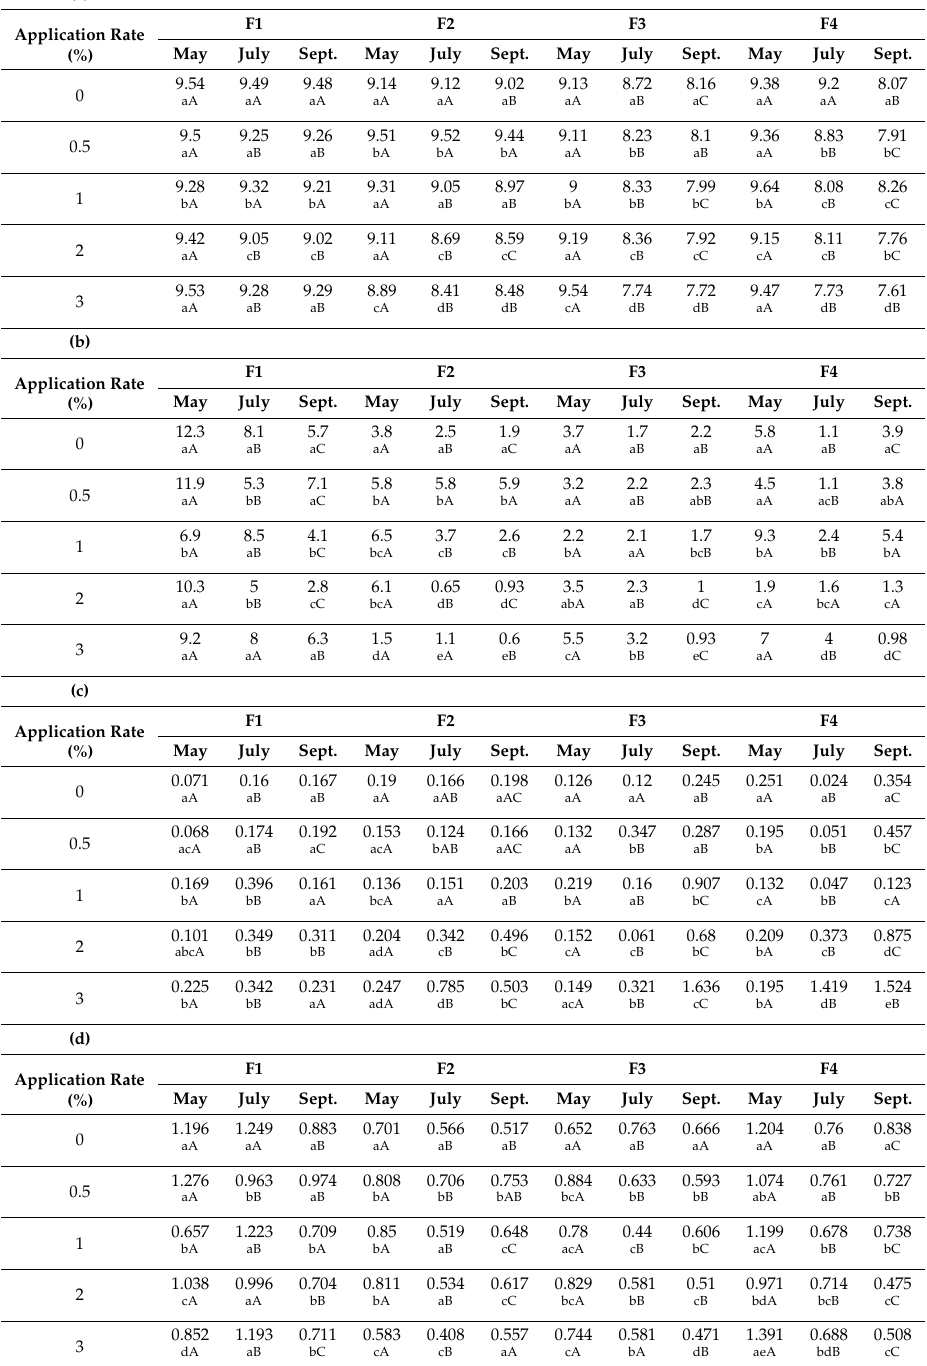
Table 9. (a). Change in pH at di ff erent application rates from May to September in all test fields. (b). Change in ESP at di ff erent application rates from May to September in all test fields. (c). Change in Ca concentration at di ff erent application rates from May to September in all test fields. (d). Change in HCO 3 concentration at di ff erent application rates from May to September in all test